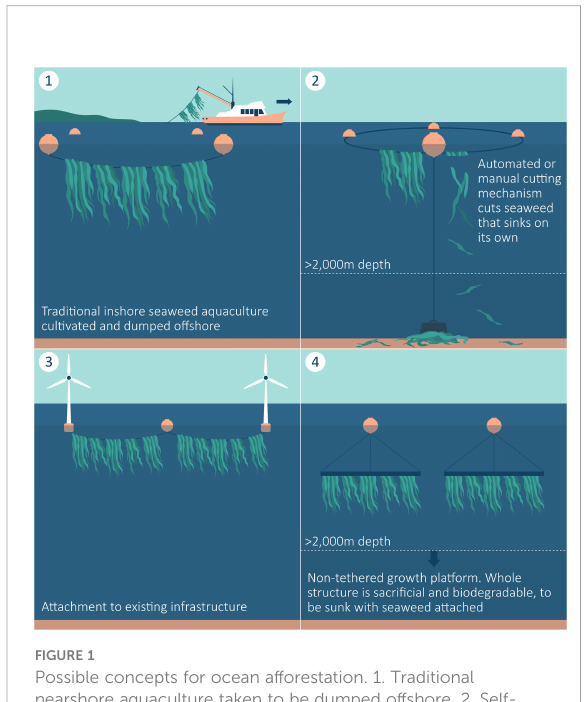
FIGURE 1 Possible concepts for ocean afforestation. 1. Traditional nearshore aquaculture taken to be dumped offshore. 2. Self- anchored growth platform sunk at the site. 3. Seaweed aquaculture infrastructure attached to existing offshore infrastructure (e.g. oil and gas infrastructure or a wind farm). 4. Free- fl oating biodegradable